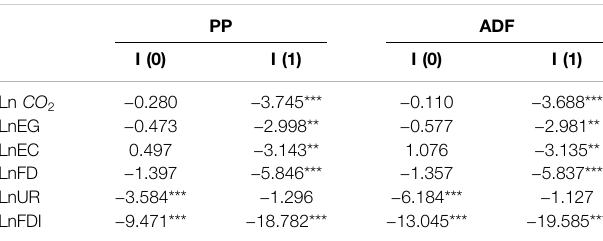
TABLE 2 | Unit root test